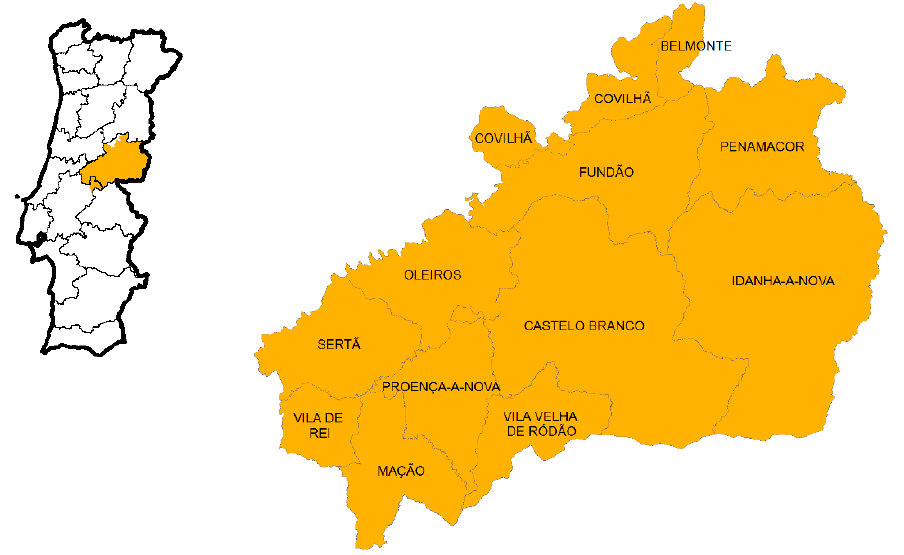
Figure 1. Geographical location of the Beira Baixa PDO cheese production area .